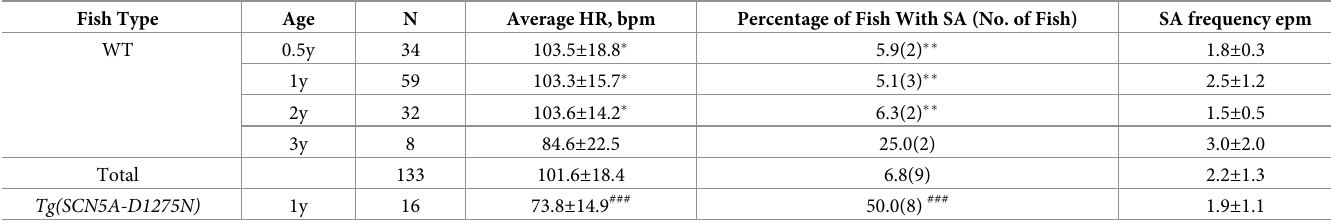
Table 1. Heart rates and SA incidence comparison in WT and Tg(SCN5A-D1275N ) transgenic fish. Fish Type